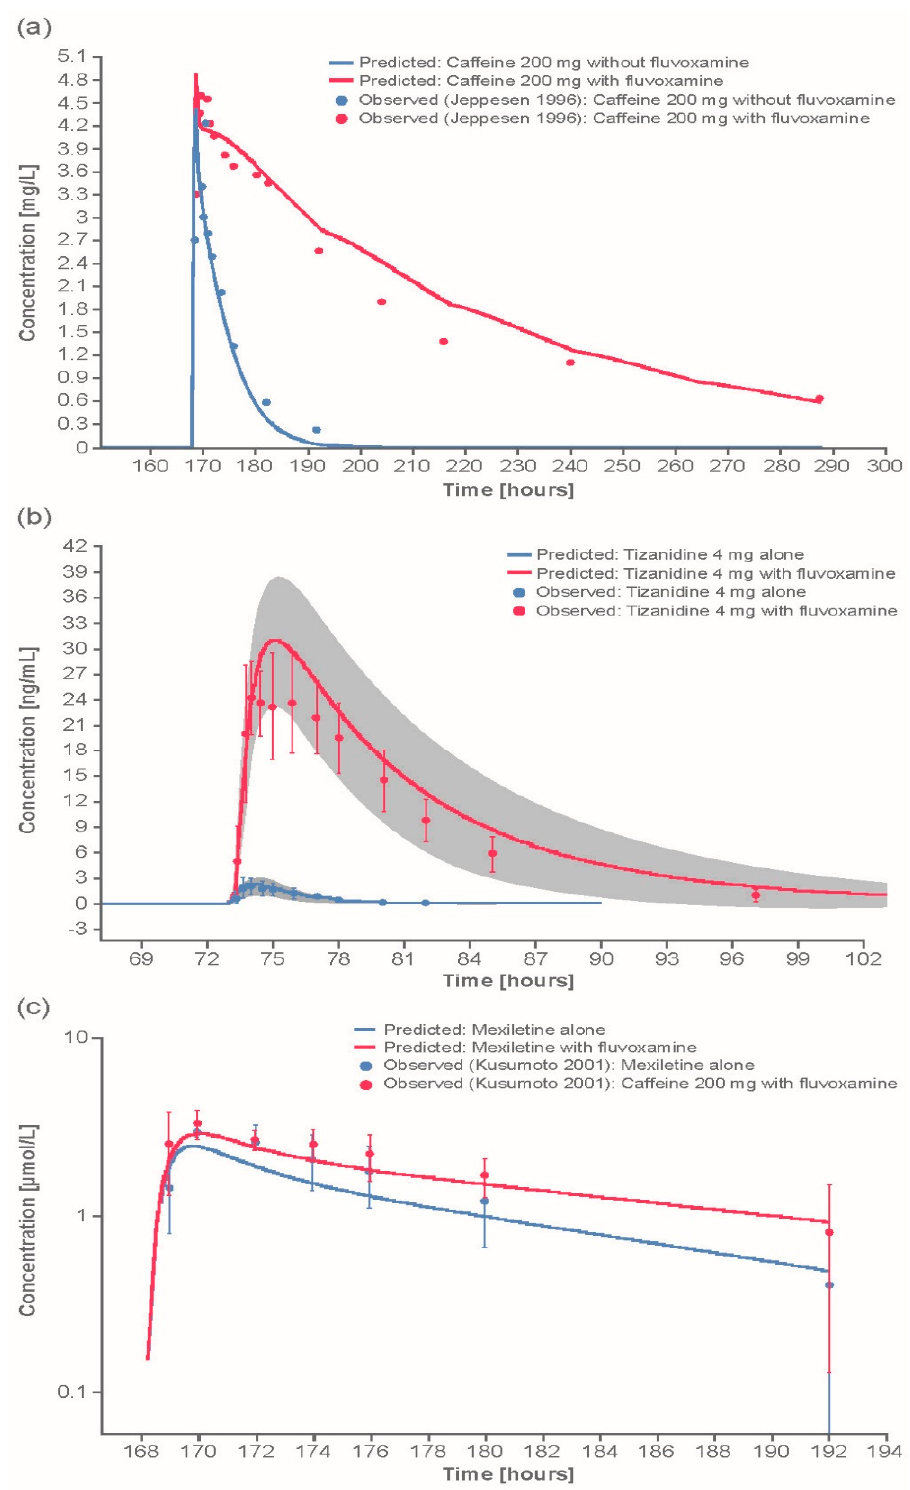
Figure 2. Example comparisons of model-predicted and observed CYP1A2 DDI outcomes: ( a ) Predicted and observed caffeine concentrations, with and without coadministration of fluvoxamine; ( b ) predicted and observed mean (± standard deviation) concentrations of tizanidine after 4 mg dose given with or without fluvoxamine using the optimized Ki value; gray area encompasses the standard deviation interval of the predicted profiles; ( c ) predicted and observed mean (± standard deviation) mexiletine concentrations with (red) and without (blue) fluvoxamine. Additional comparisons of model-predicted vs. observed DDI outcomes can be found in Supplementary Material S3. CYP, cytochrome P450.